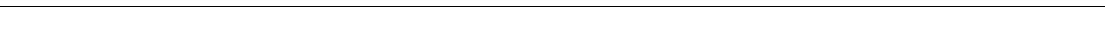
Figure 13. Highlighted Area in Southeast Portland. This area from SE 127th Avenue to SE 148th Avenue and SE Taylor Street to SE Lincoln Street contains Mill Park Preschool, North Powellhurst School, Lincoln Park Elementary, David Douglas High School, the Community Transition Program, Lincoln Park, and North Powellhurst